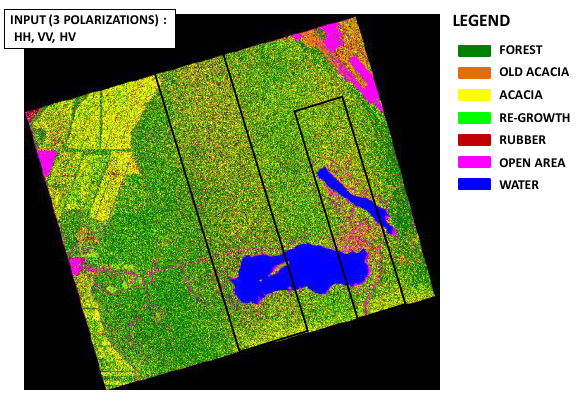
Figure 4. Land cover classification using 10 spatial resolution with 3 polarization images